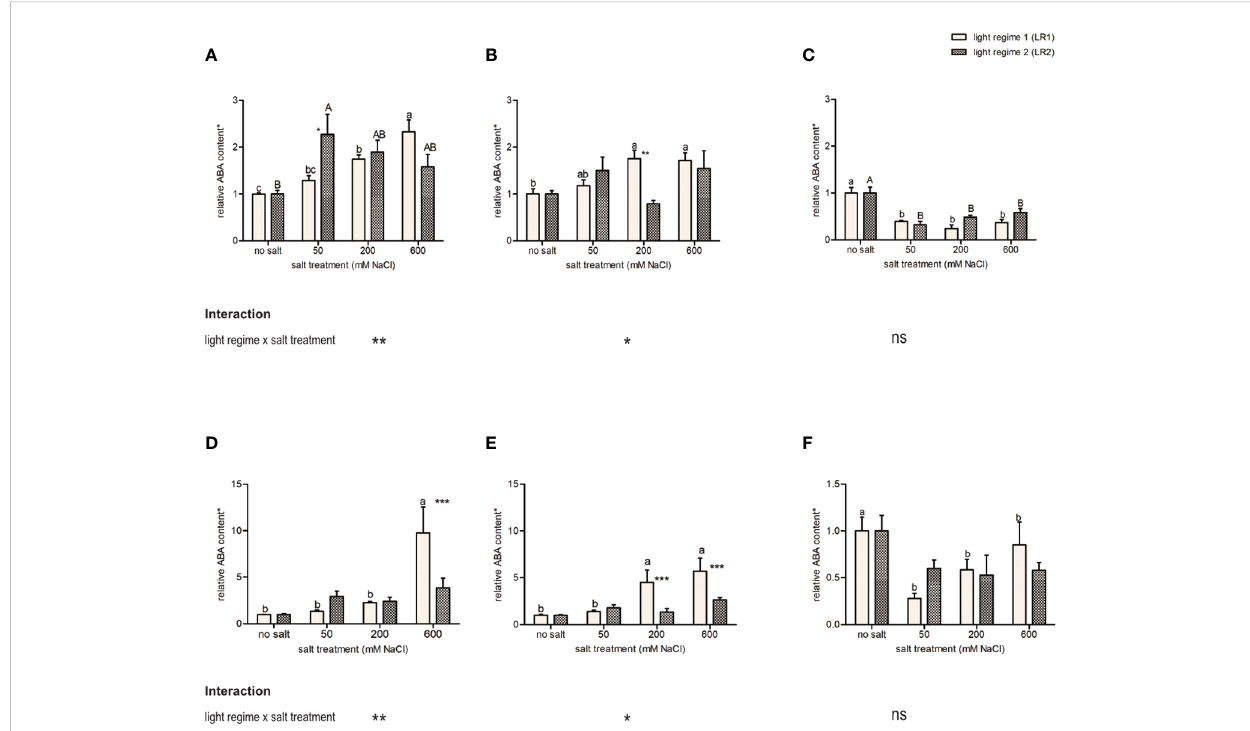
FIGURE 3 In fl uence of salt treatment and light regime on abscisic acid (ABA) content on (A – C) dry mass basis and (D – F) fresh mass basis in the leaves of 6- to 9-week-old plants. (A, D) Cochlearia of fi cinalis ; (B, E) Atriplex hortensis ; (C, F) Salicornia europaea . *Relative data of the respective control of light regime; bar represents means ± SEM of n = 8 pools of three individual plants each from two independent experiments. Small letters indicate signi fi cant differences between salt treatments in light regime 1 (LR1, greenhouse) in alphabetical order from highest to lowest; capital letters indicate signi fi cant differences between salt treatments in light regime 2 (LR2, indoor farming) in alphabetical order from highest to lowest; asterisks indicate signi fi cant differences between LR1 and LR2 in between one salt treatment; interaction shows signi fi cantly different interactions between salt treatments and light regimes tested by two-way ANOVA, followed by post-hoc Bonferroni test ( p ≤ 0.05) (* ≤ 0.05, ** ≤ 0.01, *** ≤ 0.001); ns, not signi fi